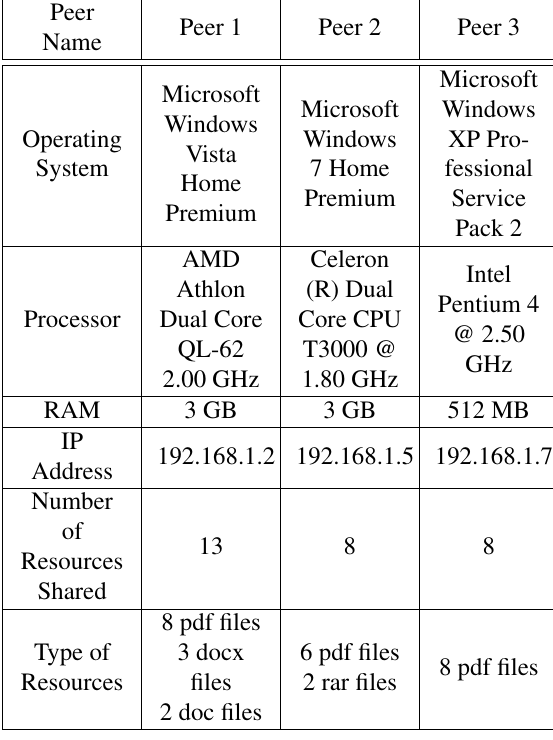
Table 4. Gnutella flooding peers test bed